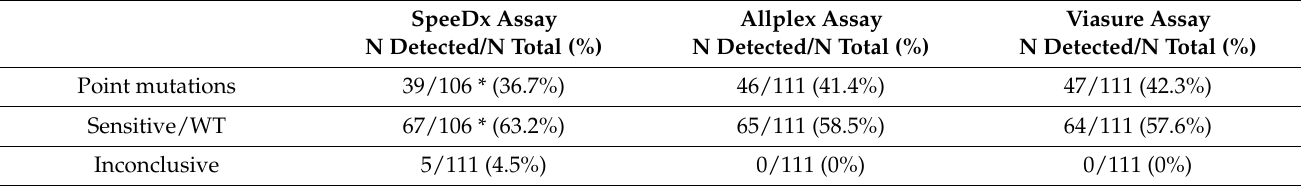
Table 1. ResistancePlus ® MG panel kit (SpeeDx assay), Allplex TM MG & AziR Assay (Allplex assay), and VIASURE macrolide resistance-associated mutations (23SrRNA) Real time PCR detection kit (Viasure assay)